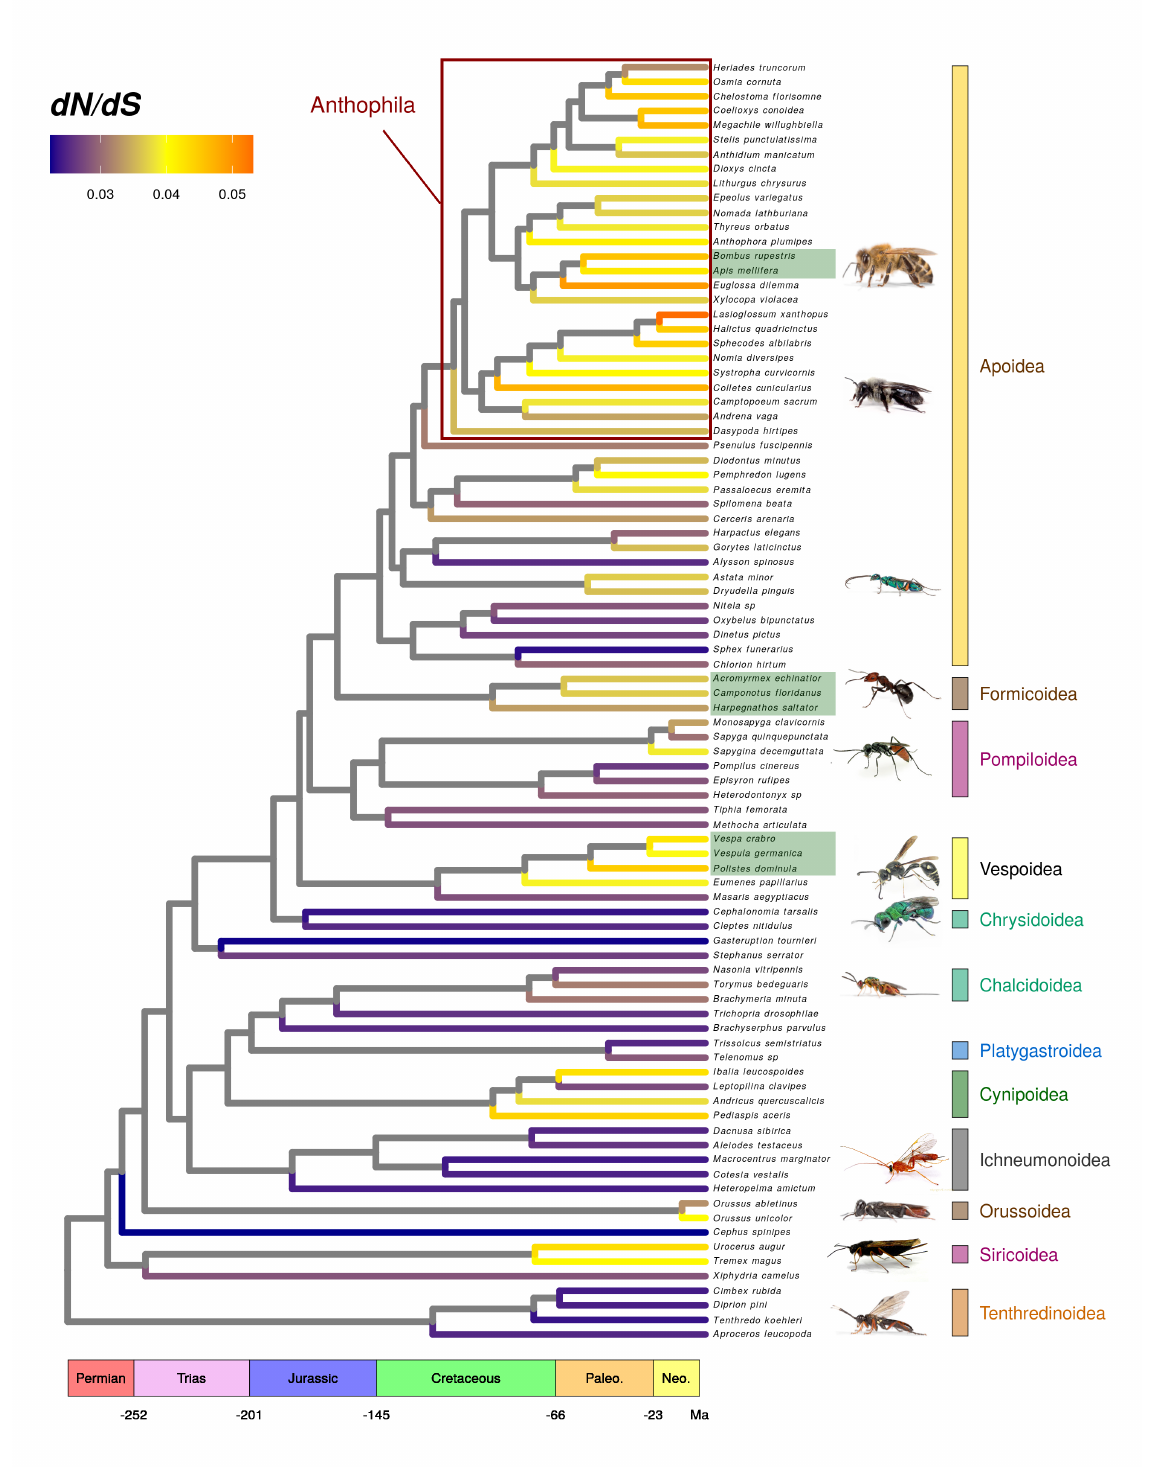
Figure S2 – Genomic dN/dS ratios for 88 species of Hymenoptera. dN/dS ratios esti- mated on terminal branches using 134 genes with data for each of the displayed species are represented on the chronogram inferred by Peters et al. (2017). Green rectangles around labels indicate eusocial